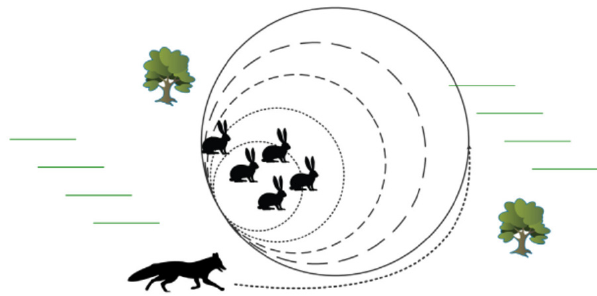
Figure 5. Hunting behavior of the Red Fox.